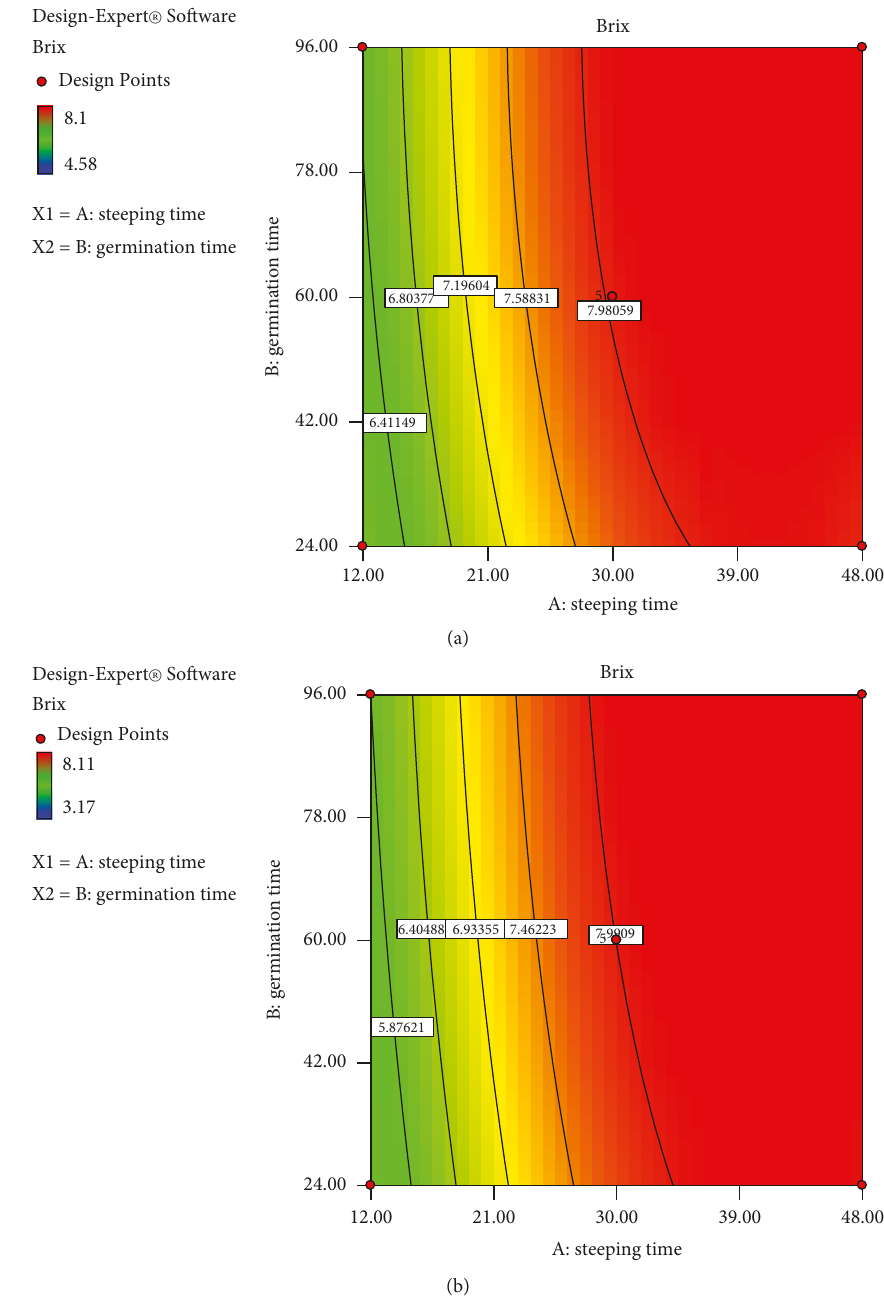
Figure 1: Contour plot for steeping time, germination time, and Brix value of (a) barley malt and (b) quinoa